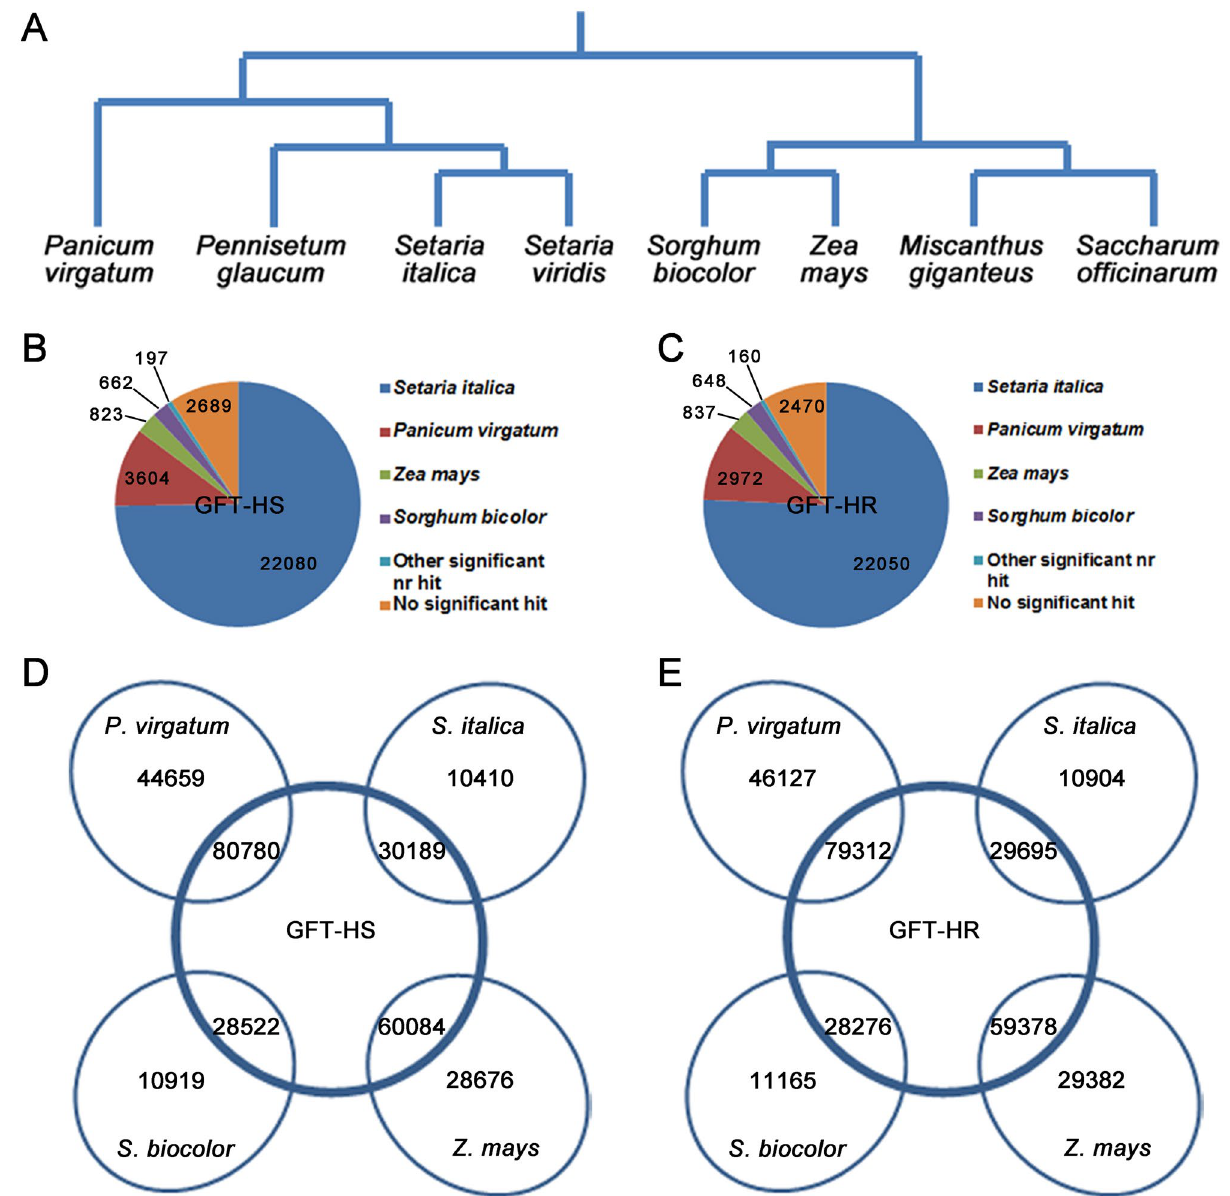
Figure 3. Comparative analysis of de novo assembled transcriptomes of green foxtail with related species in Poaceae. Phylogenic tree for selected species ( A , adopted from Li and Brutnell 8 ), assembled HS GFT ( B ) and HR GFT ( C ) contigs with BlastX top hits to those of Setaria italica, Panicum virgatum, Zea mays and Sorghum bicolor (https:// phyto zome. jgi. doe. gov/ pz/- portal. html#). GFT contigs without any hit were compared against the NCBI nr database. tBlastn comparisons of transcriptomes between assembled GFT-HS ( D ) or GFT-HR ( E ) with those of selected species. The value in each of the overlapping areas represents the number of genes with significant homology (e ≤ 0.05, match ≥ 70%) in the GFT